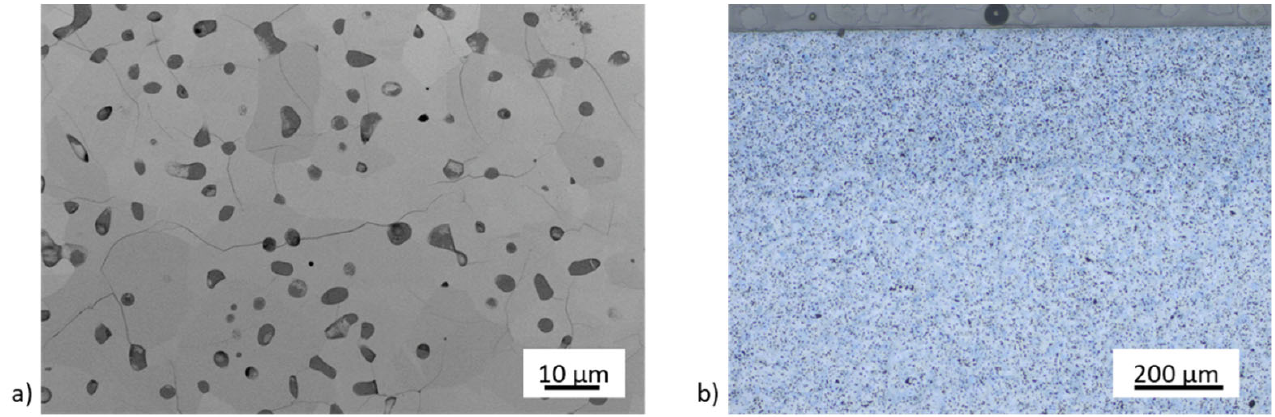
Figure 12. FESEM micrograph with microcracks ( a ) and an optical microscopic image showing a porous edge region ( b ) in the TiO x substrate .